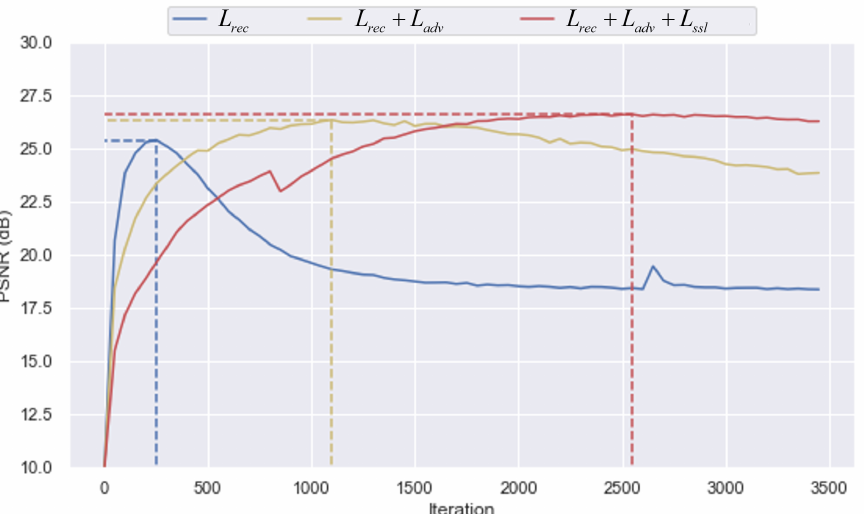
Figure 7. PSNR vs. iteration plot. The plot demonstrates the instability of DIP and the ability of our self-supervision loss to stabilize the optimizing process and avoid